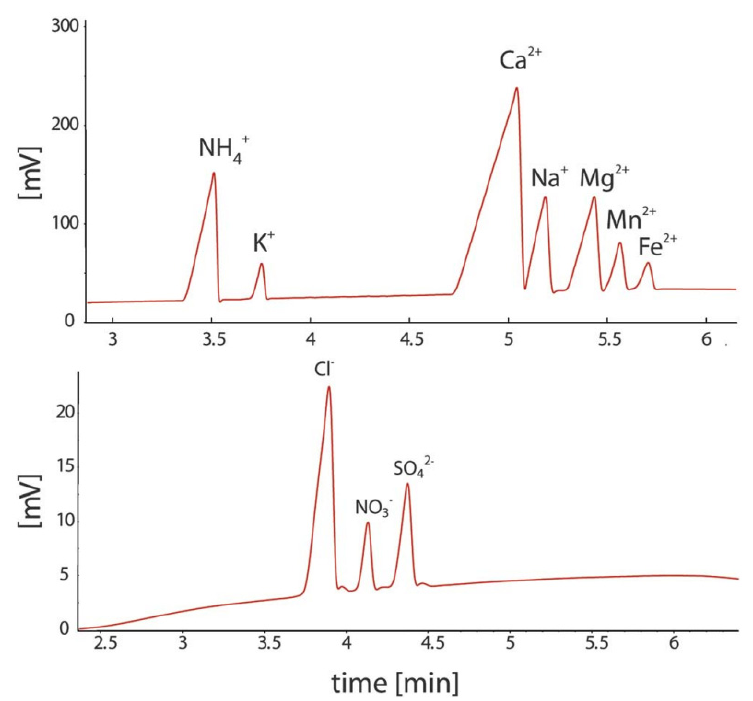
Figure 8. Electropherograms recorded for the CE determination of anions and cations in sediment pore water using a portable CE system with contactless C 4 D conductivity detection and hydrodynamic injection [52]. Sample: 700 μ M NH 4+ , 100 μ M K + , 1500 μ M Ca 2+ , 500 μ M Na + , 320 μ M namic injection [52]. Sample: 700 µ M NH 4+ , 100 µ M K + , 1500 µ M Ca 2+ , 500 µ M Na + , 320 µ M Mg 2+ , Mg 2+ , 120 μ M Mn 2+ , and 70 μ M Fe 2+ for the cations and 610 μ M Cl − , 120 μ M NO 3 − , and μ M SO 42 − for 120 µ M Mn 2+ , and 70 µ M Fe 2+ for the cations and 610 µ M Cl − , 120 µ M NO 3 − , and µ M SO 42 − for the anions. CE conditions: capillary—55 cm, 50 μ m I.D., BGE—11 mM His, 50 mM AcOH, 1.5 mM the anions. CE conditions: capillary—55 cm, 50 µ m I.D., BGE—11 mM His, 50 mM AcOH, 1.5 mM 18-crown-6, 0.1 citric acid, V: ±15 kV. (Permission from RSC is not required). 18-crown-6, 0.1 citric acid, V: ± 15 kV. (Permission from RSC is not